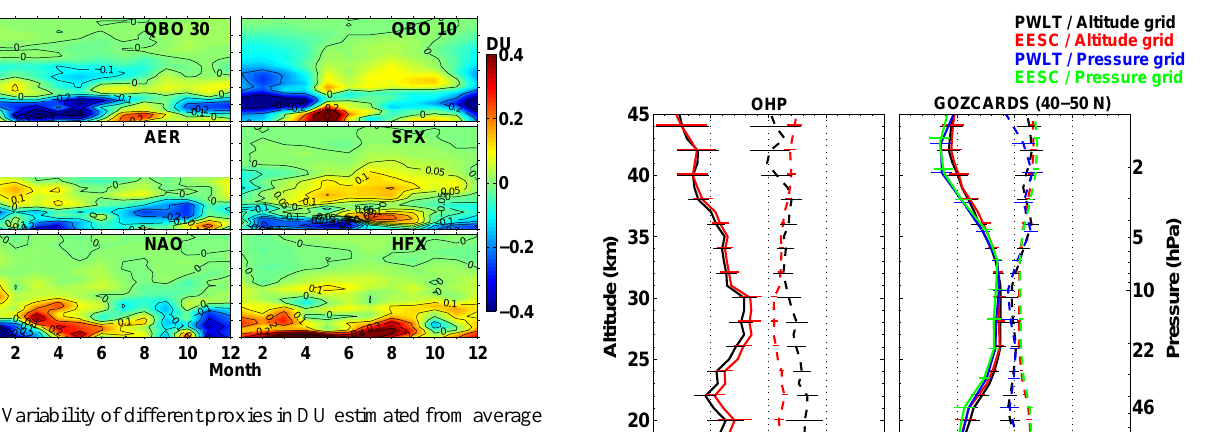
Fig. 7. Variability of different proxies in DU estimated from average ozone anomalies of the vertical profiles at OHP.